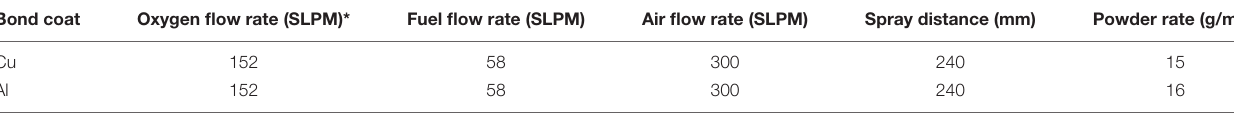
TABLE 1 | HVOF spraying parameters for the metallic bond coats. Bond coat Oxygen flow rate (SLPM)* Fuel flow rate